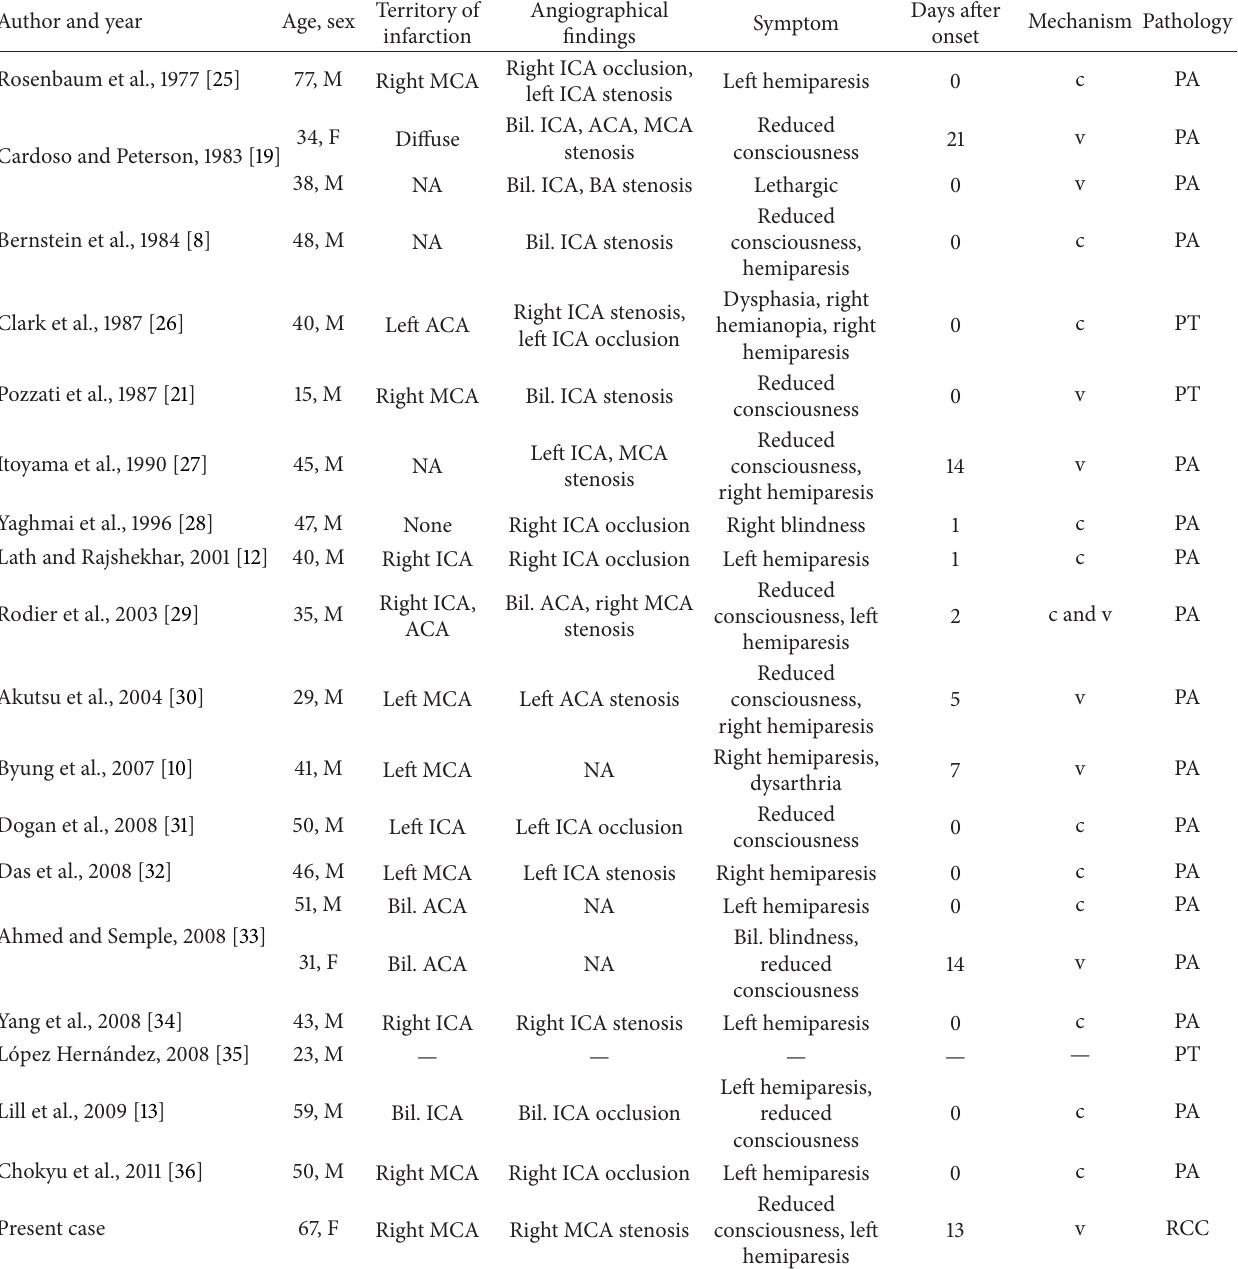
Table 2: Reported cases of cerebral ischemia following pituitary